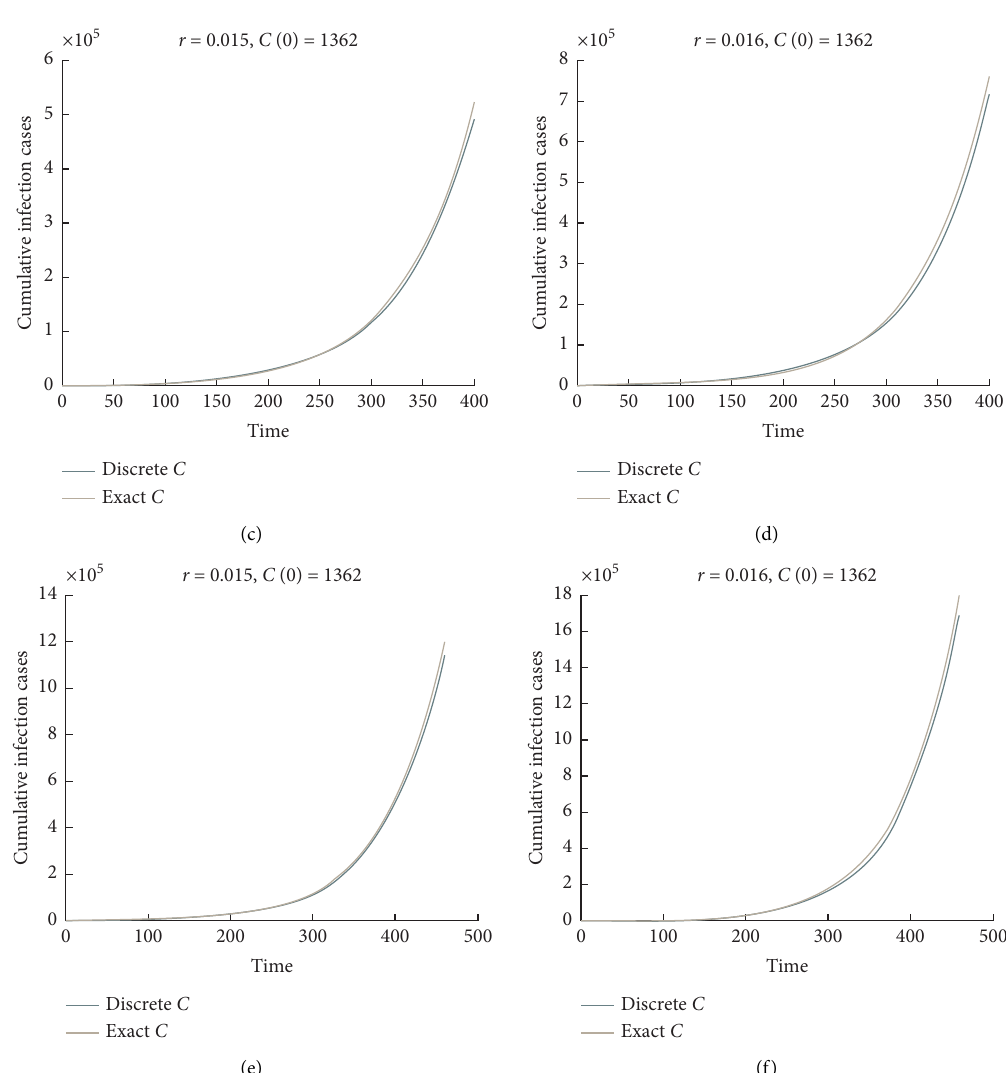
Figure 11: Prediction of cumulative infection cases in Saudi Arabia based on logistic growth rate models with an infection rate of 0.015 for (a) 360 days, (c) 400 days, and (e) 460 days and with an infection rate of 0.016 for (b) 360 days, (d) 400 days, and (f) 460 days.